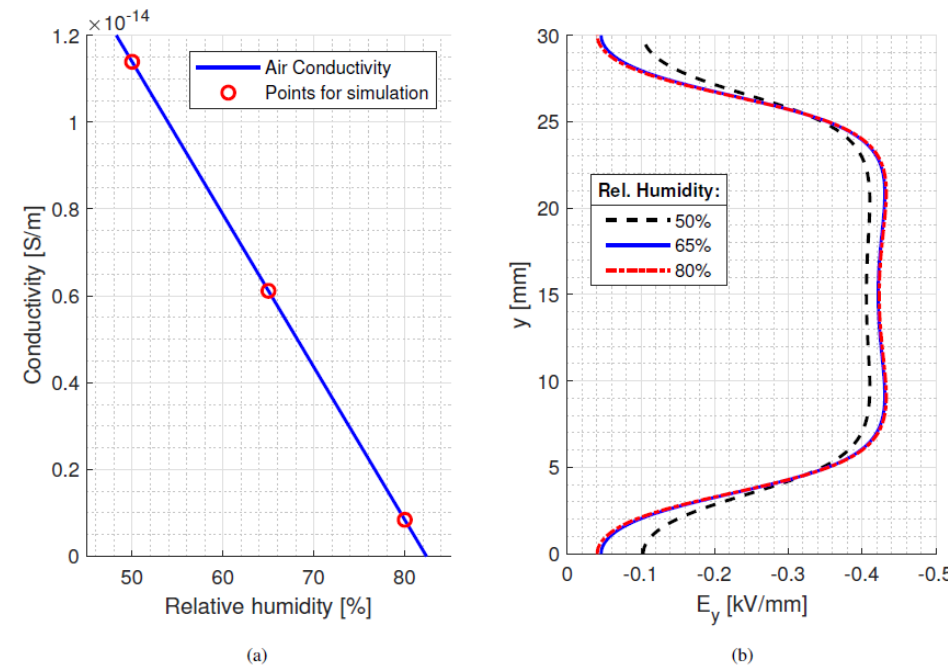
Figure 8. ( a ) Values of air conductivity at 25 °C as a function of relative humidity [18], and ( b ) impact on surface tangential field (considering the parameters of Table 1).